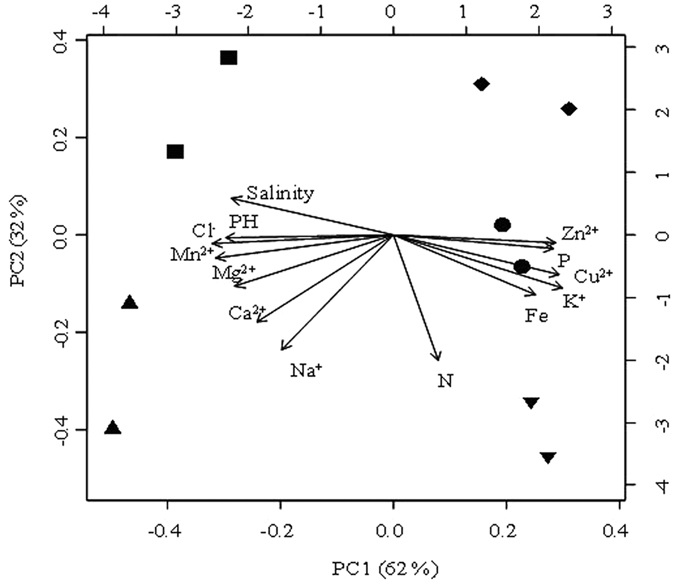
A PCA map showing the 10 sampling sites and their correlation with trace elements.Note: pH, Cl−, Ca2+, Mg2, K+, Na+, Fe2, Mn2, Cu2, Zn2, Sanlinity, total N (nitrogen) and total P (phosphorus) were used to evaluate the influence of each variable. The longer the arrow, the greater the influence; the smaller the angle between two arrows, the closer their correlation. Solid squares (■) and pright triangles (▲) denote Qijiaojing (QJJ) and Aydingkol (AK) salt lake sites in Xinjiang Province; inverse triangles (▼), diamonds (♦) and black circles (•) denote Jiangcheng (JC), Heijing (HJ), Yunlong(YL) salt mine sites in Yunnan Province, respectively.